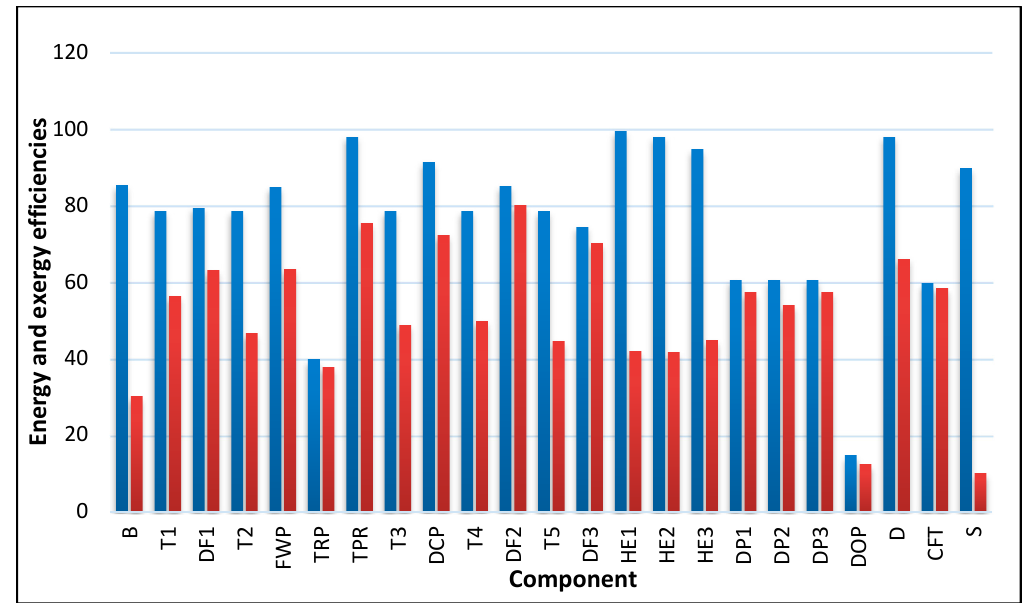
Figure 6. Energy and exergy efficiencies of each component and the system.